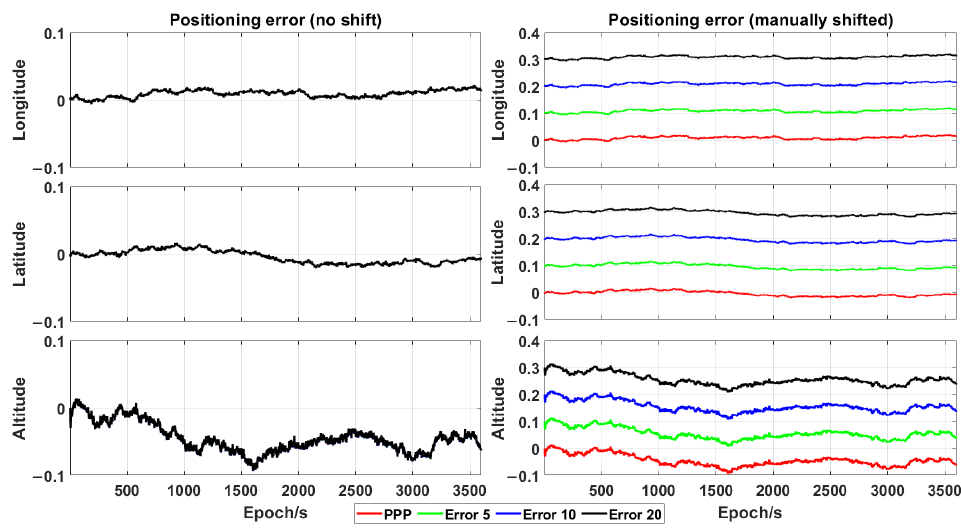
Figure 9. Positioning error (expressed in metres) vs. initial position errors at HKLT station (the red curve comprises the position data obtained by relying on the initial position sensed by means of a static PPP, while the green, blue and black curves are the position data manually shifted by 0.1, 0.2 and 0.3 m, respectively, from the initial position having additional errors of 5, 10 and 20 m, respectively).